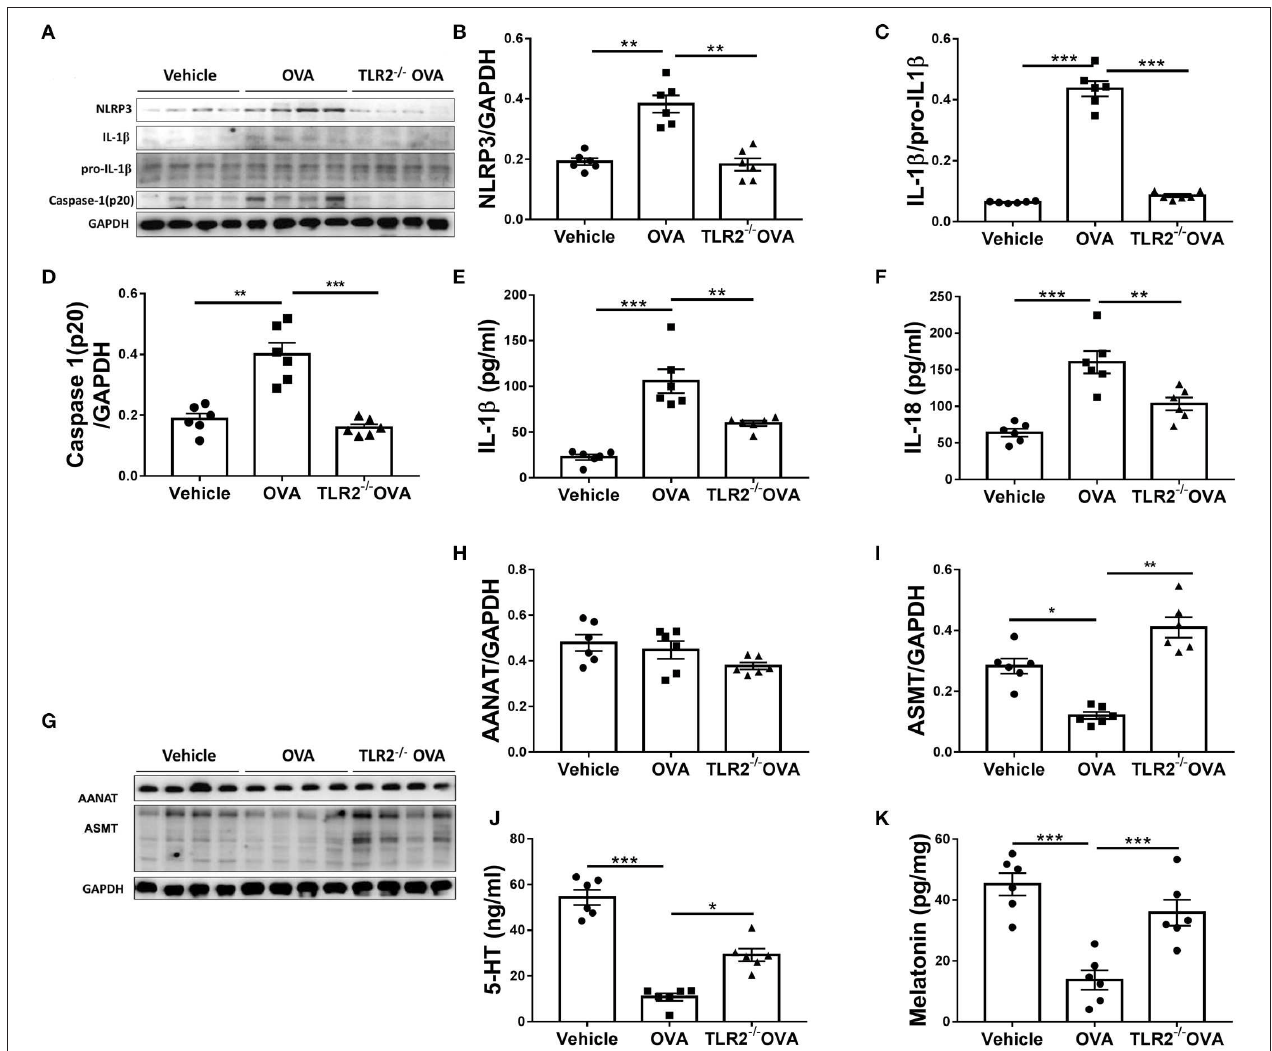
FIGURE 3 | OVA-induced activation of NLRP3 inflammasome and decrease of melatonin biosynthesis are TLR2 dependent. (A) NLRP3, mature IL-1 β , pro-IL-1 β , and caspase1(p20) western blot analysis. (B–D) Relative ratio of NLRP3 to GAPDH, IL-1 β to pro-IL-1 β , and caspase1(p20) to GAPDH. (E,F) ELISA analysis of IL-1 β and IL-18 in BALF. (G) Western blot analysis of AANAT and ASMT in lung tissues. (H,I) Relative ratio of AANAT or ASMT to GAPDH. (J,K) The levels of 5-HT in BALF and melatonin in the lung homogenate were analyzed by ELISA. * p < 0.05, ** p < 0.01, *** p <